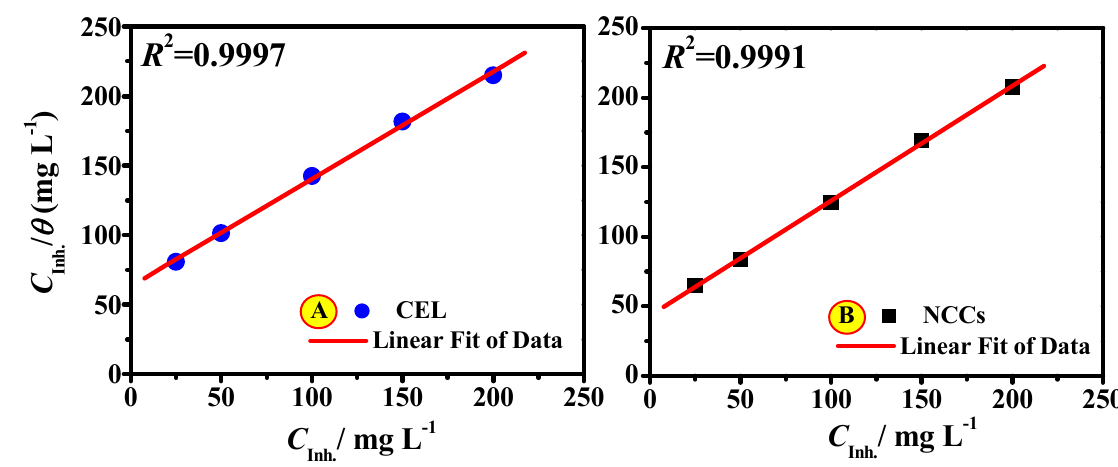
Figure 11. Langmuir adsorption isotherms for adsorption of ( A ) CEL and ( B ) NCC on the SS316 alloy in 2.0 M HCl.